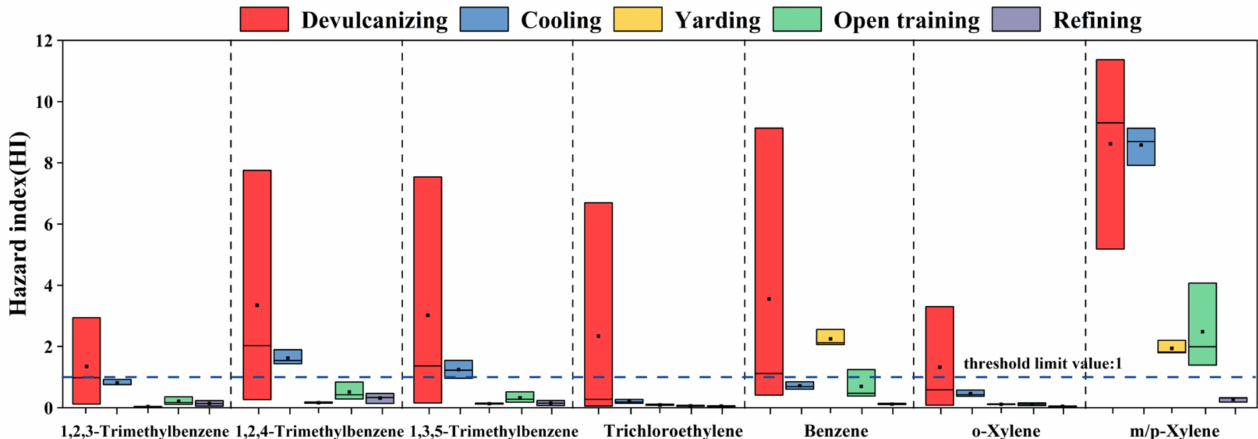
Figure 3. HI value of compounds from each process. The box represented the 25–75th percentiles of HI values. The middle square and middle line represented the mean and the median values of HI values,